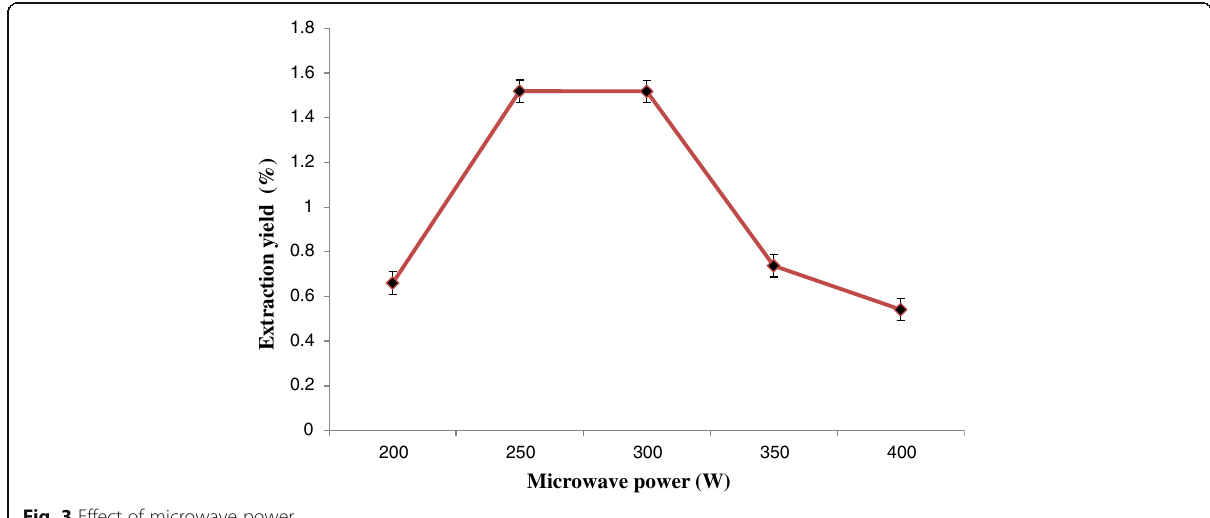
Fig. 3 Effect of microwave